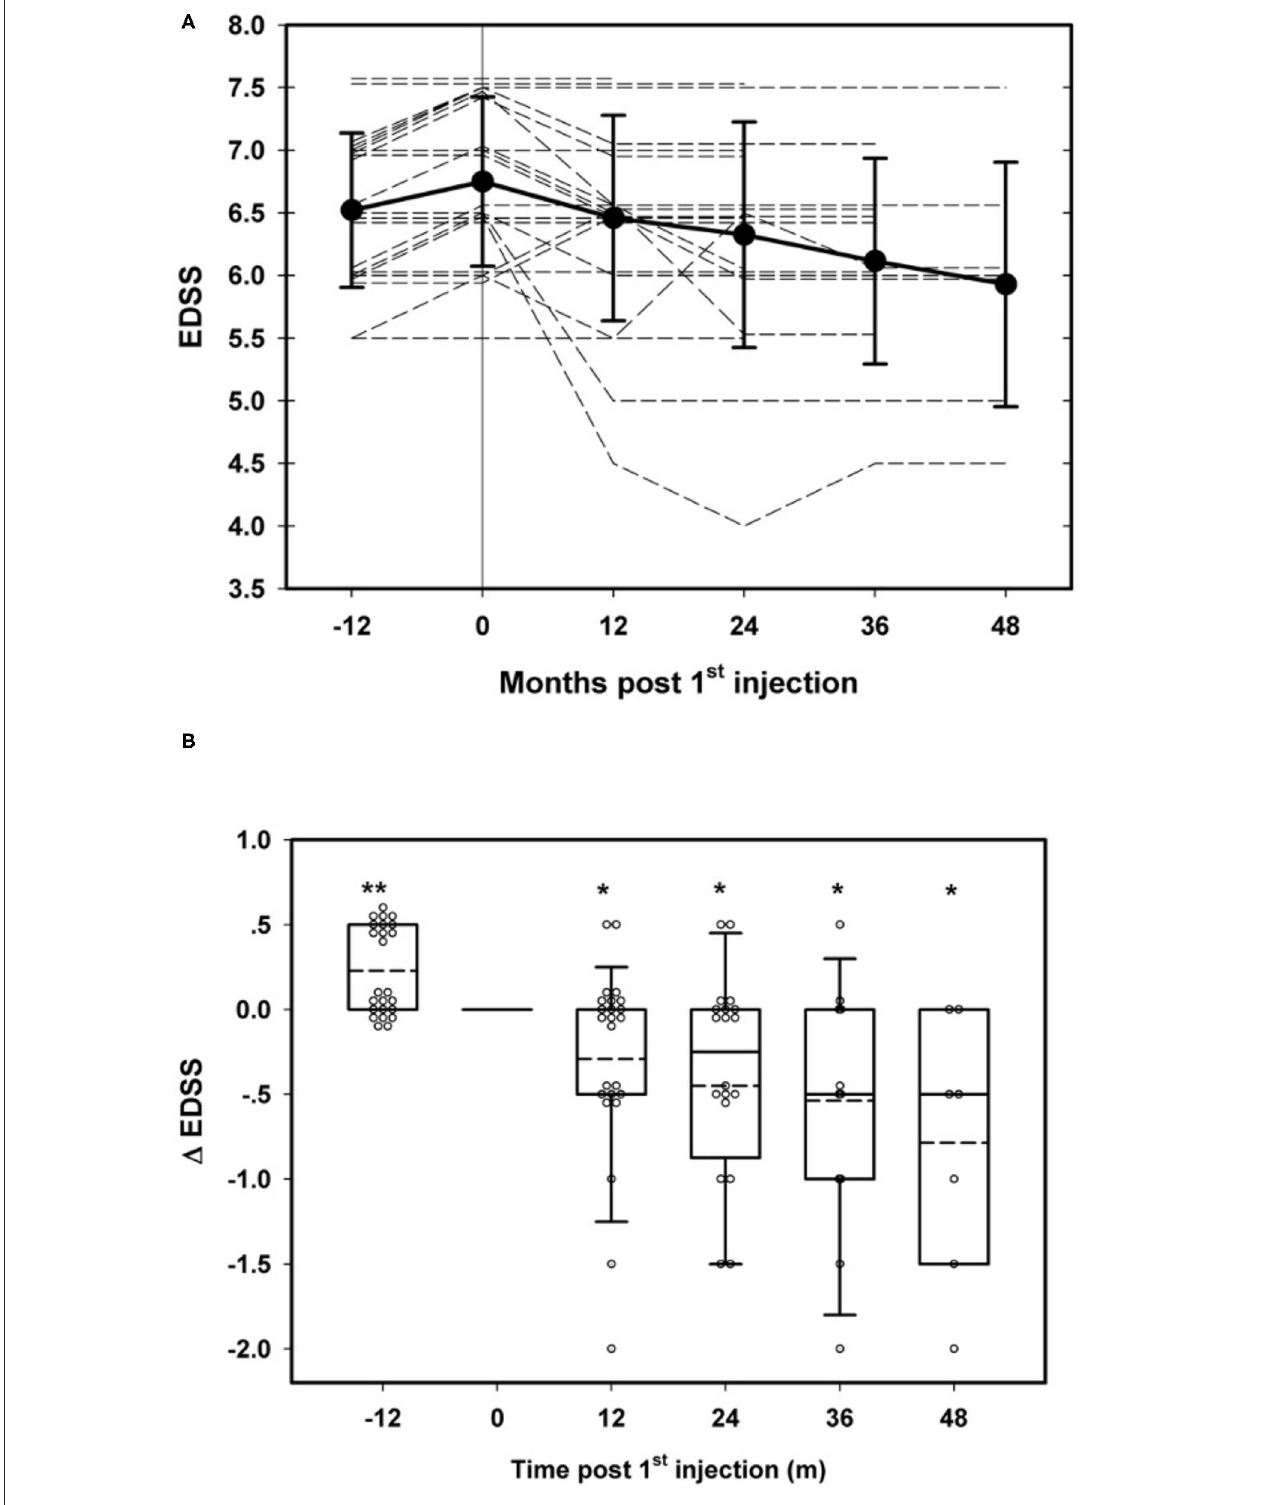
FIGURE 2 | Long-term clinical effects of repeated transplantation of mesenchymal stem cells (MSCs) in multiple sclerosis (MS). (A) Changes in EDSS in individual patients before and after MSC transplantation. (B) Rate of EDSS change before and after MSC transplantations. * p < 0.05, **p < 0.01, at the respected time points vs baseline values (Wilcoxon signed rank